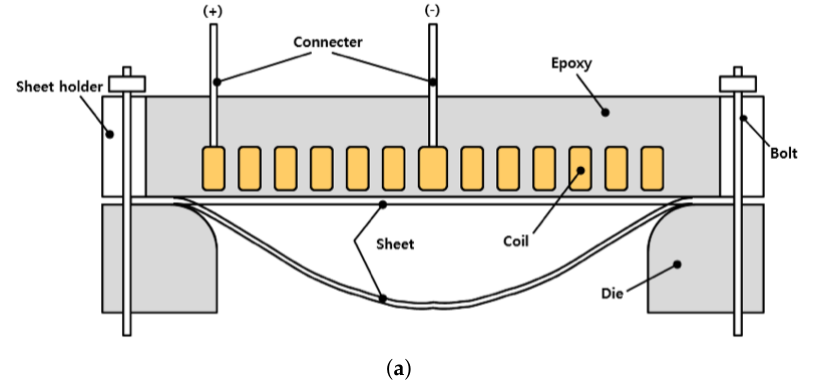
Figure 4. Measured input current at a charging voltage of 9kV.